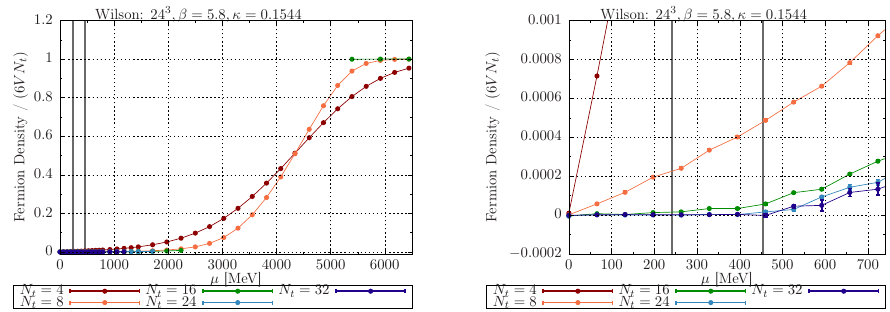
Figure 2: Fermion density as a function of the quark chemical potential. The vertical grey lines correspond to m π / 2 and m N / 3 respectively.